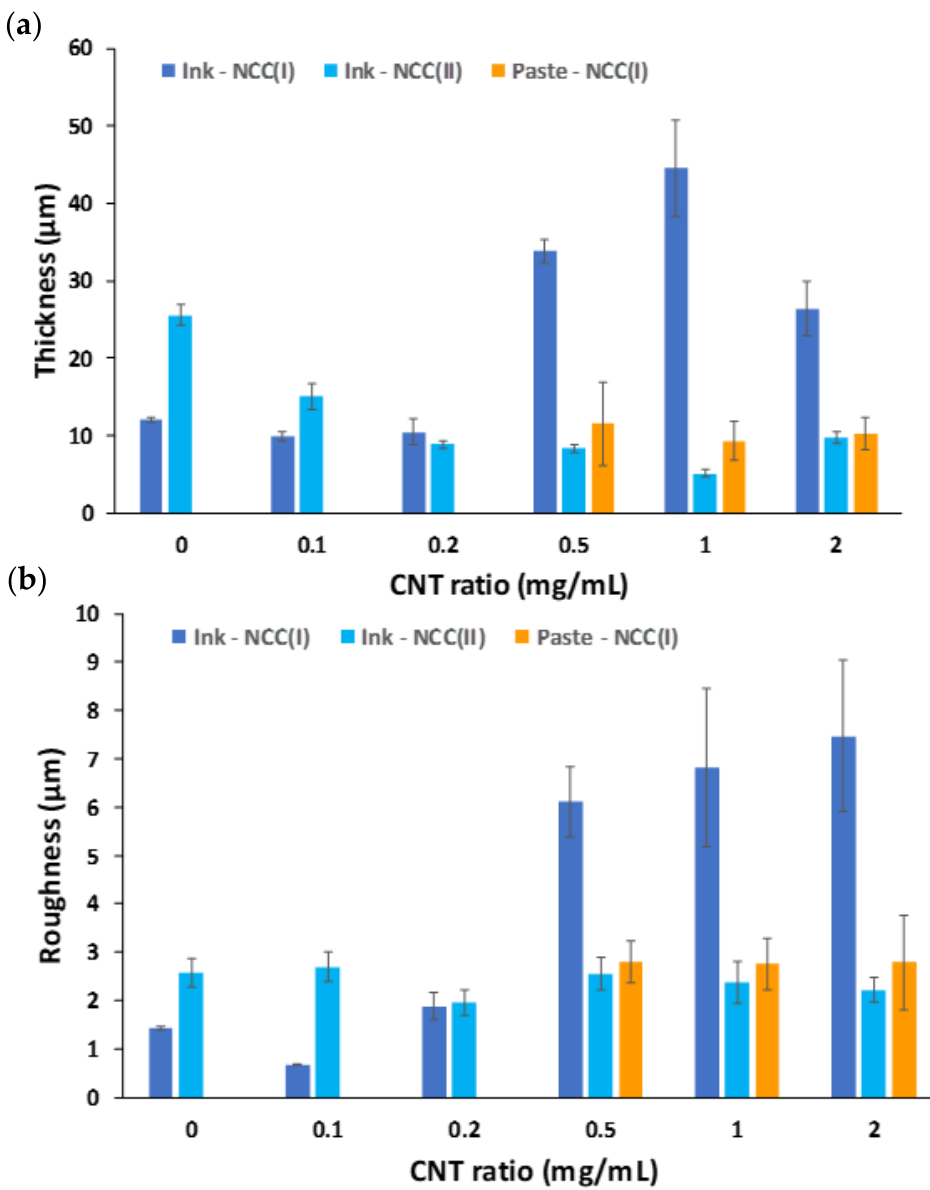
Figure 6. Film thicknesses ( a ) and roughnesses ( b ) corresponding to samples coming from sprayed inks or rod-coated pastes.